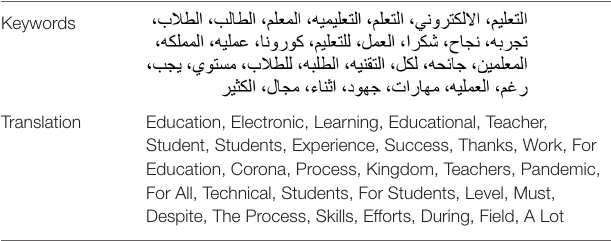
Table 6 | The keywords and their English translation for Figure 6